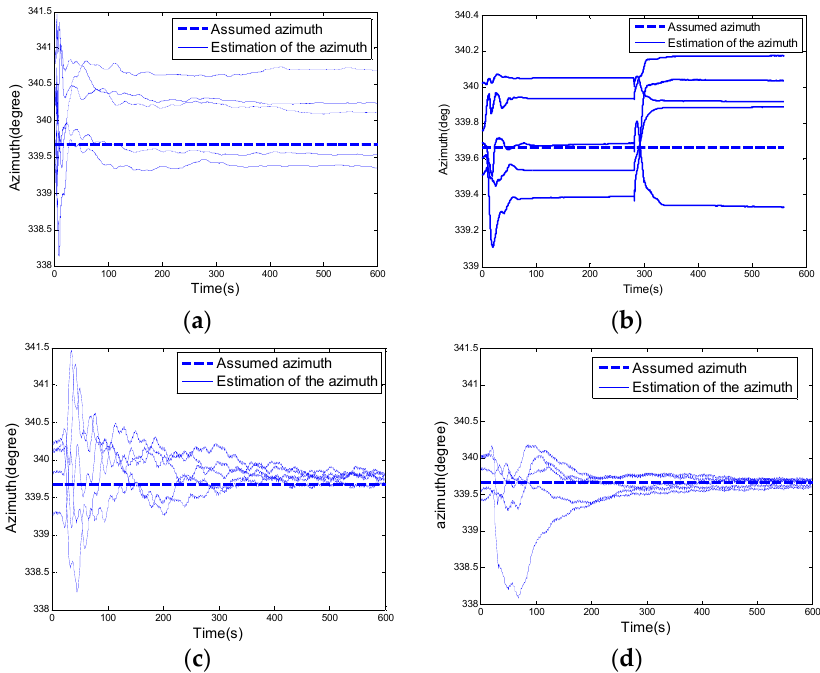
Figure 6. ( a ) The accuracy of the heading angle using the fixed-position alignment; ( b ) The accuracy of the heading angle using the two-position alignment; ( c ) The accuracy of the heading angle using the continuous rotation method; ( d ) The accuracy of the heading angle using the continuous rotation based on the extended observation model.